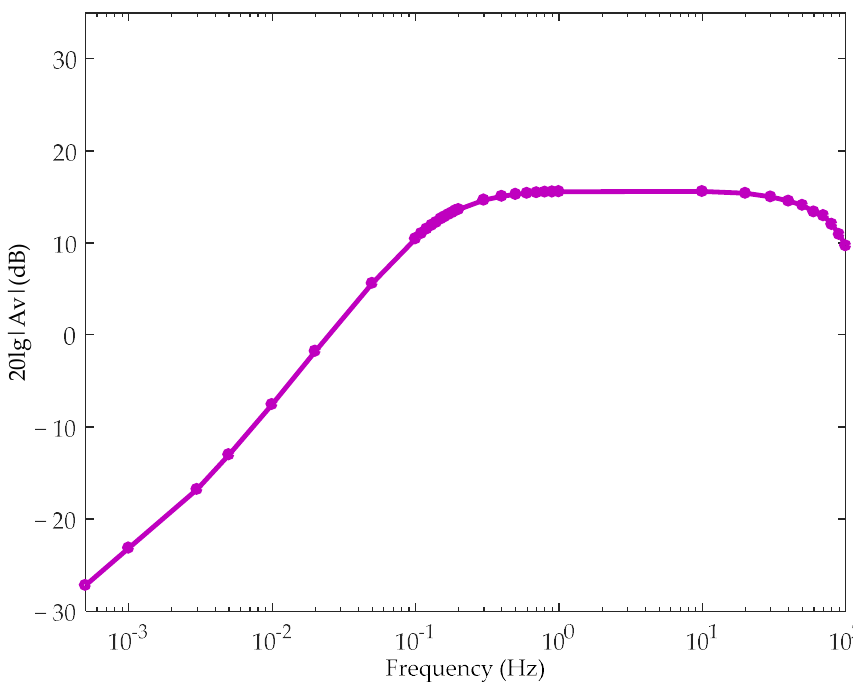
Figure 10. Amplification frequency response of the detection circuit.